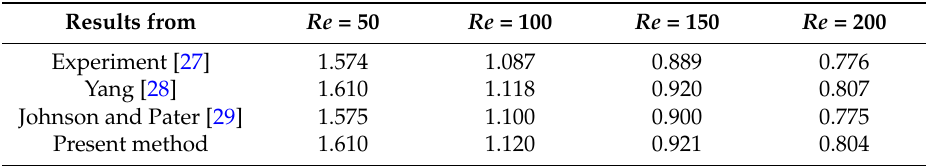
Table 1. Drag coefficient C d for the flow past a sphere at different Reynolds ( Re ) number. Results